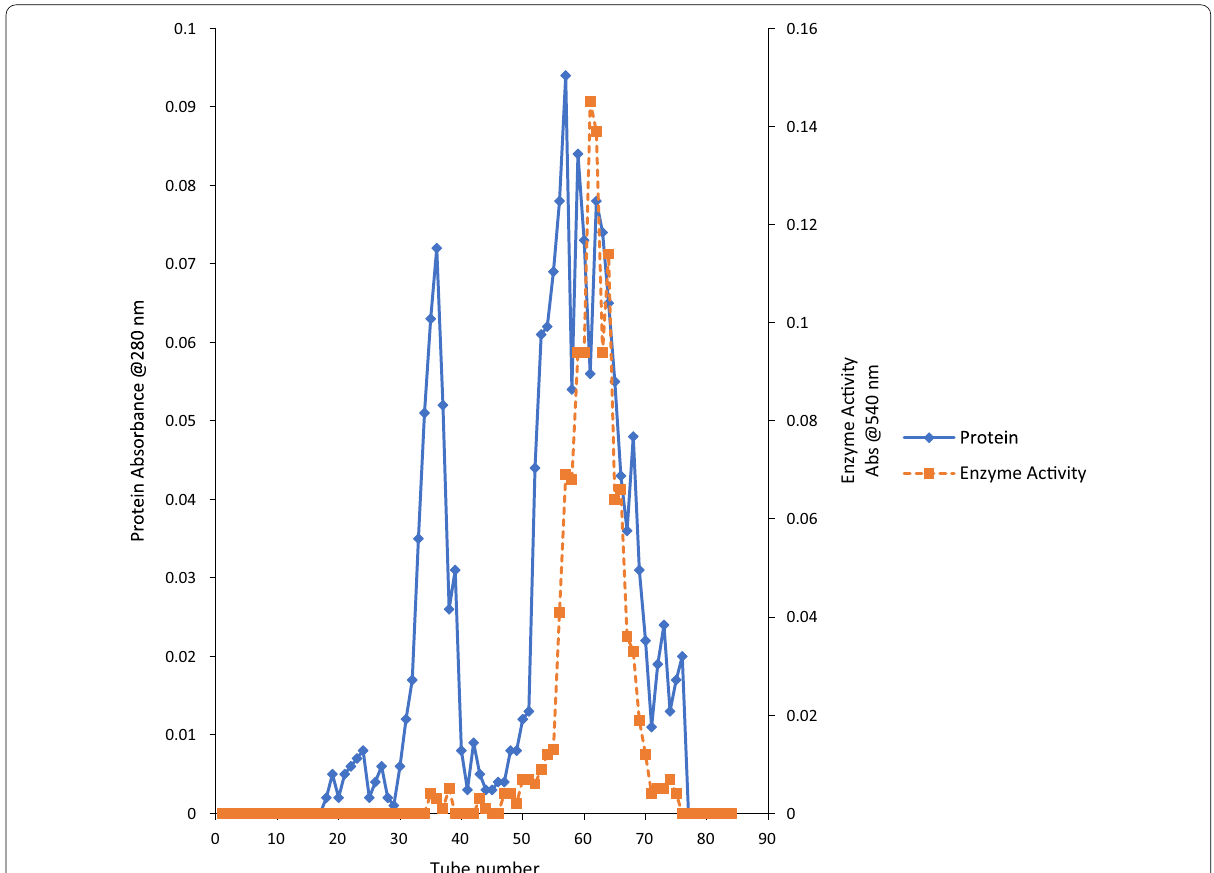
Fig. 7 Elution profile of chitinase produced by Streptomyces albus on gel